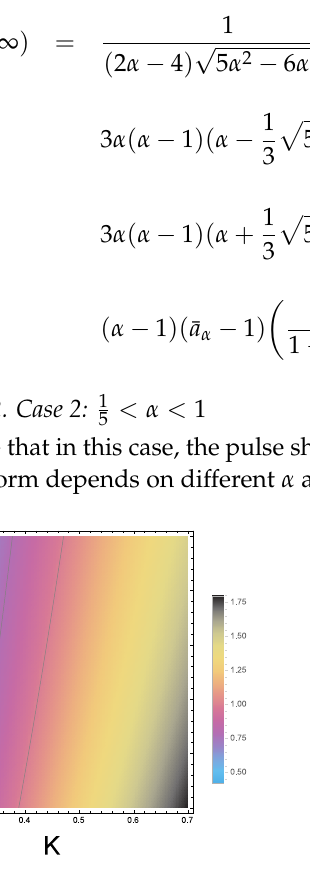
Figure A1. The generalized QEXP pulse dynamics for various amplitudes A 1 and different deforma- tions